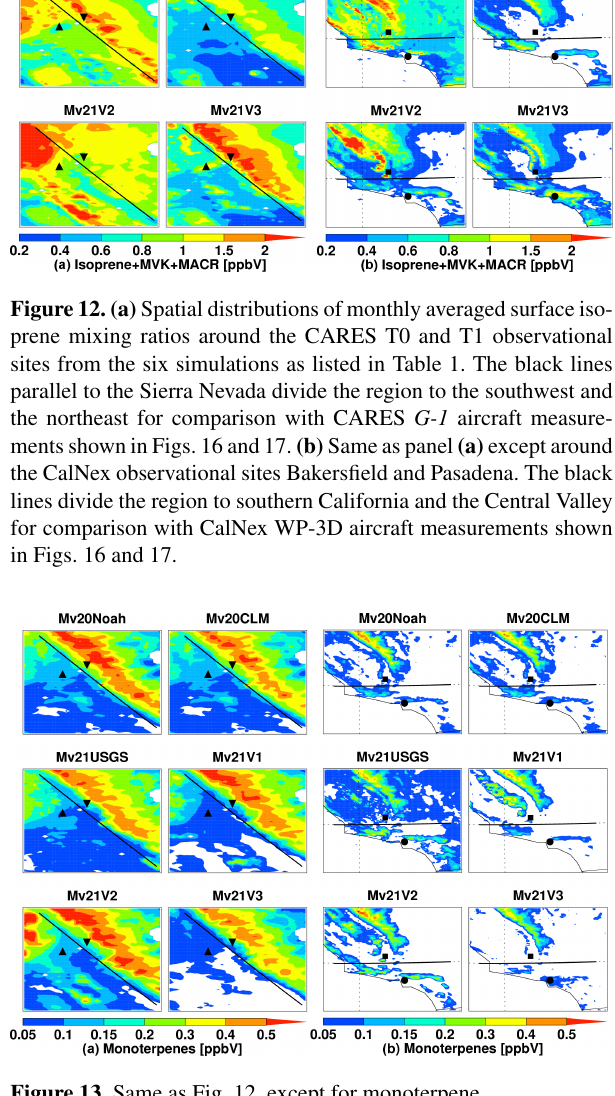
Figure 13. Same as Fig. 12, except for